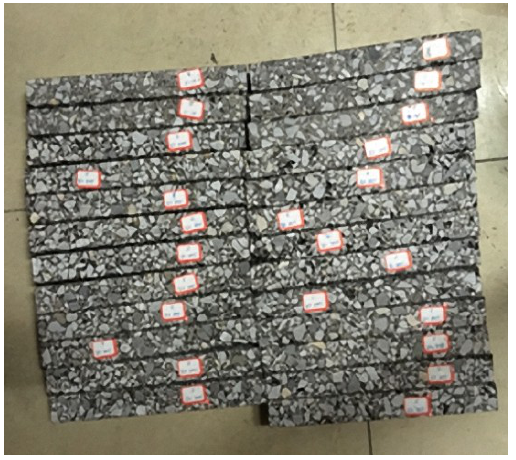
Figure 5. Standard trabecular test pieces. Table 5. Aggregate types and numbers of different asphalt mixtures.